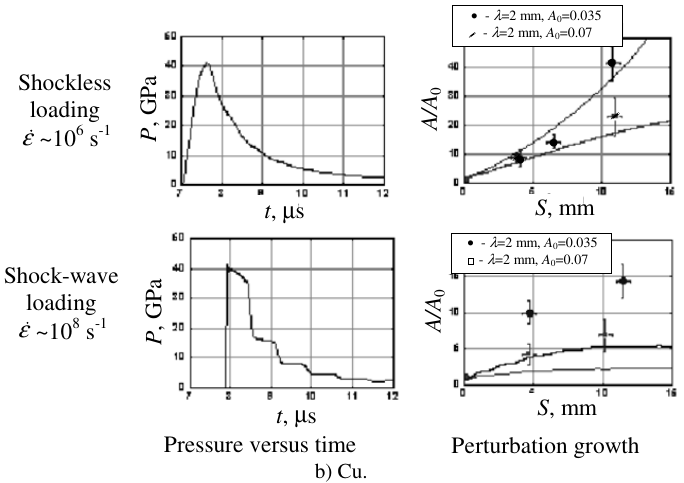
Fig. 3. Calculations of perturbation growth with use of relaxation